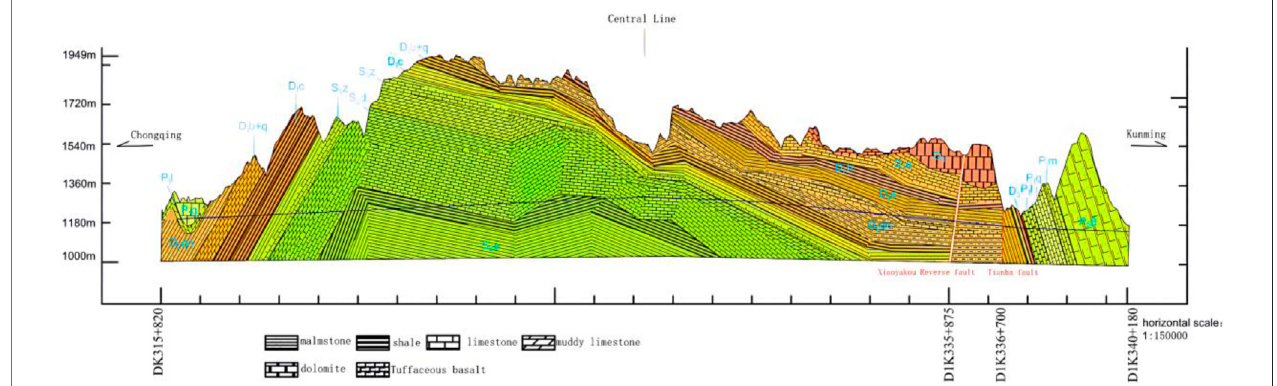
FIGURE 1 | Longitudinal section of the YL tunnel.